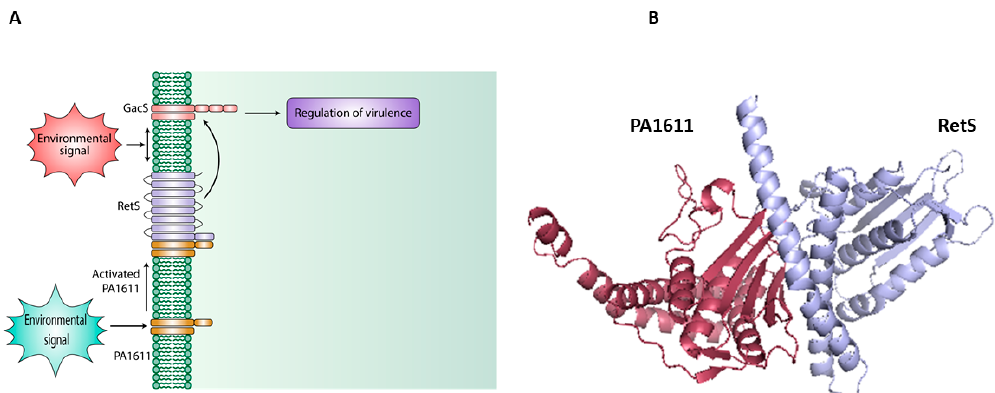
Figure 4. Schematic diagram of the direct protein-protein interaction mediated signaling using the PA1611-RetS interaction model as an example [96]. ( A ) Canonical TC Sensor GacS phosphorylates its response regulator GacA to regulate virulence in P. aeruginosa ; however, under yet unknown environmental signals, HHK PA1611 is activated and binds to HHK RetS. Under such conditions, GacS is again free to phosphorylate its cognate response regulator and mediate downstream signaling. ( B ) A docked complex for homology models for PA1611 and RetS showing predicted interacting surfaces.